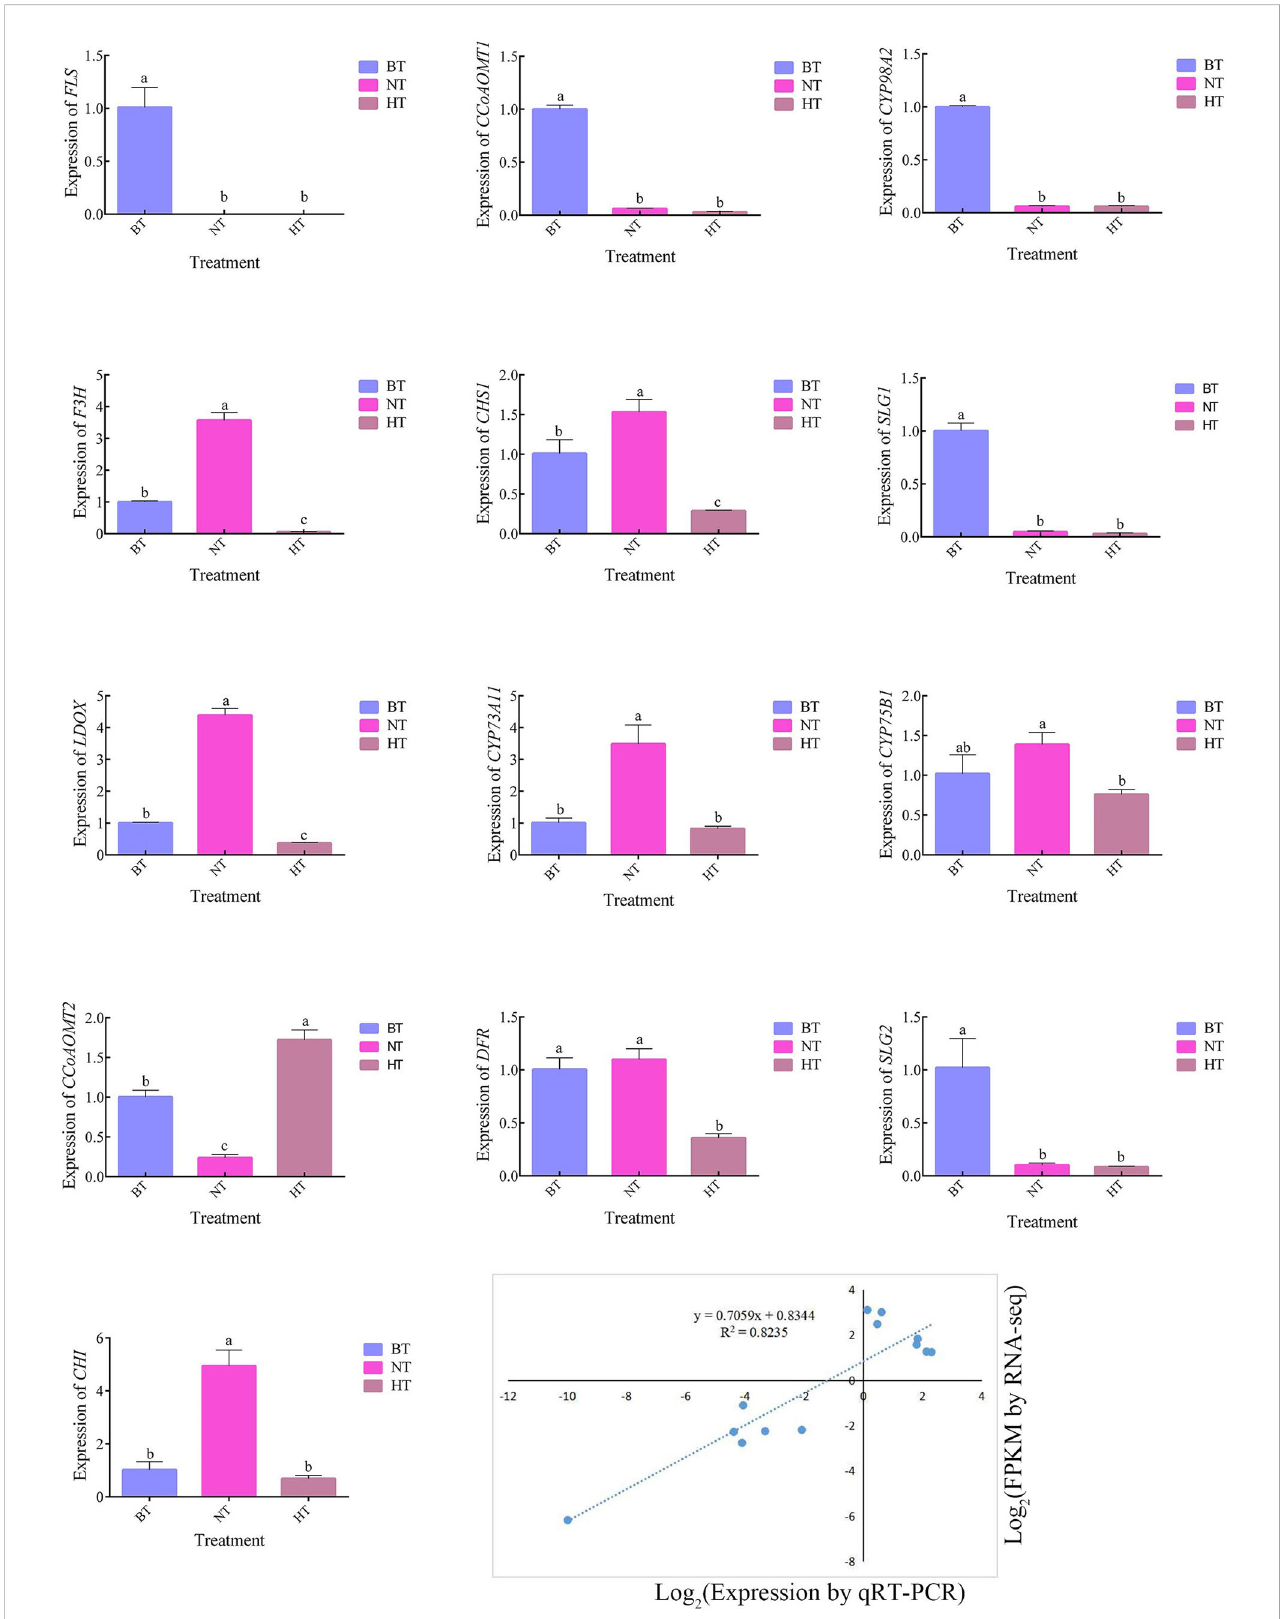
FIGURE 6 The genes of the anthocyanin and fl avonoid synthesis pathways in the transcriptome were veri fi ed by qRT − PCR. BT was set as the reference group for each temperature treatment, in which the gene expression level was recorded as 1. The different letters indicate signi fi cant differences among different treatments according to Duncan ’ s test (p <